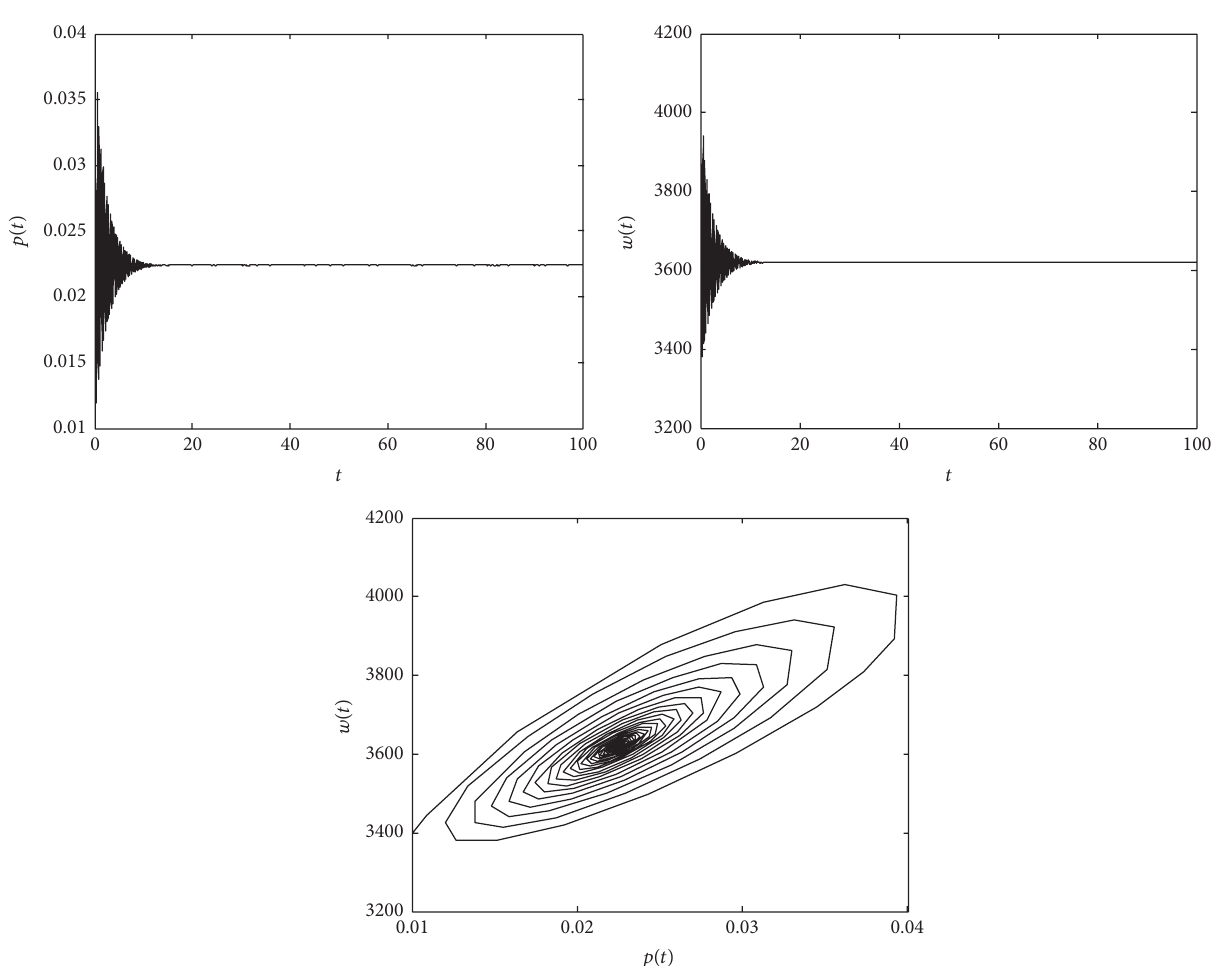
Figure 1: State plot and phase plot of uncontrolled system (2) with 𝛼 = 1120 .